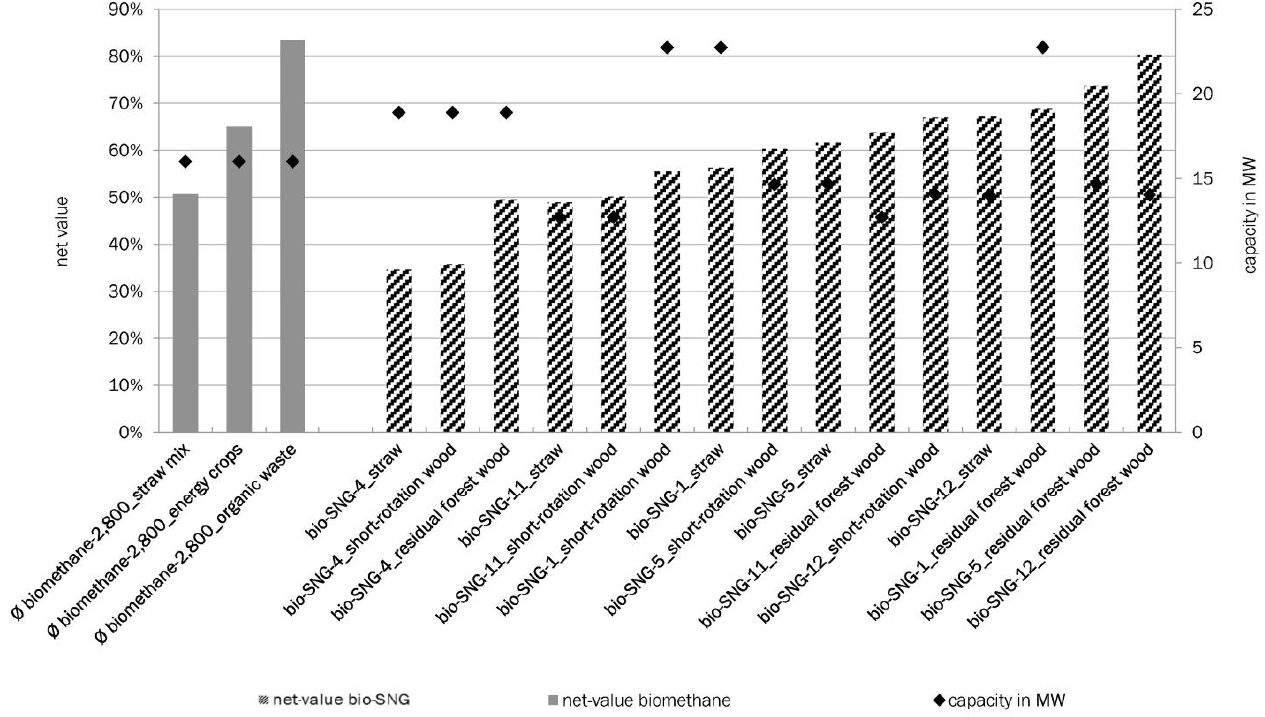
Figure 7. Biochemical conversion and thermochemical conversion net value comparison on the basis of capacity range. Reprinted from [9].